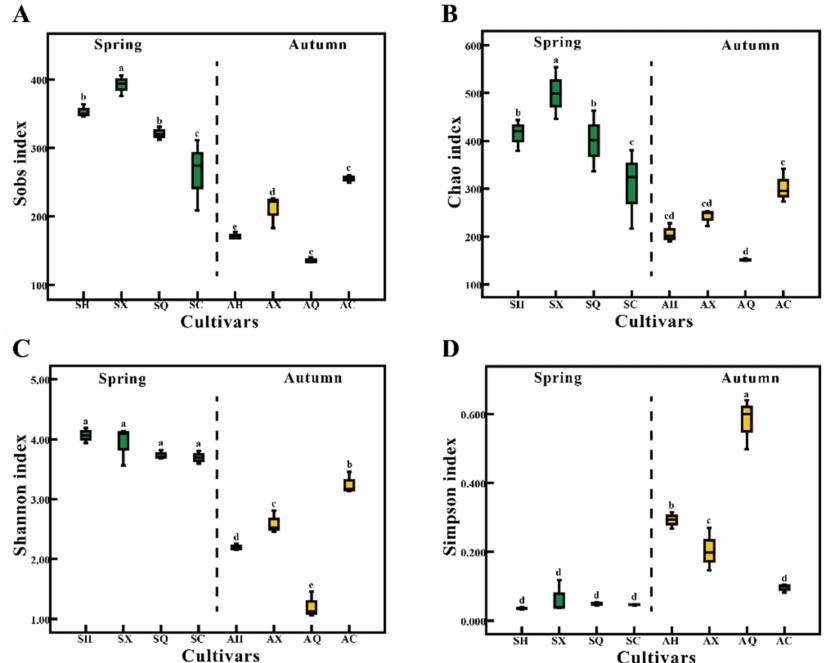
Figure 1. Alpha diversity analysis of the endophytic fungal communities of four different mulberry cultivars in spring and autumn. ( A ) Sobs; ( B ) Chao; ( C ) Shannon; ( D ) Simpson. The x -axis indicates the mulberry cultivar and the y -axis represents the observed value of different indices based on OTU abundance. n = 3 for each cultivar. Bars with the different letters indicate a significant difference between means by one-way ANOVA and Duncan’s multiple test ( p < 0.05). Values represent the mean. Error bars indicate ± standard deviation. Abbreviations: SH, SX, SQ, and SC represent fungal communities from “Hong Guo No.2”, “Xin Lunjiao”, “Chuan Sang No.7637”, and “Changguo Sang” in spring, respectively. AH, AX, AQ, and AC represent fungal communities from “Hong Guo No.2”, “Xin Lunjiao”, “Chuan Sang No.7637” and “Changguo Sang”, respectively, in